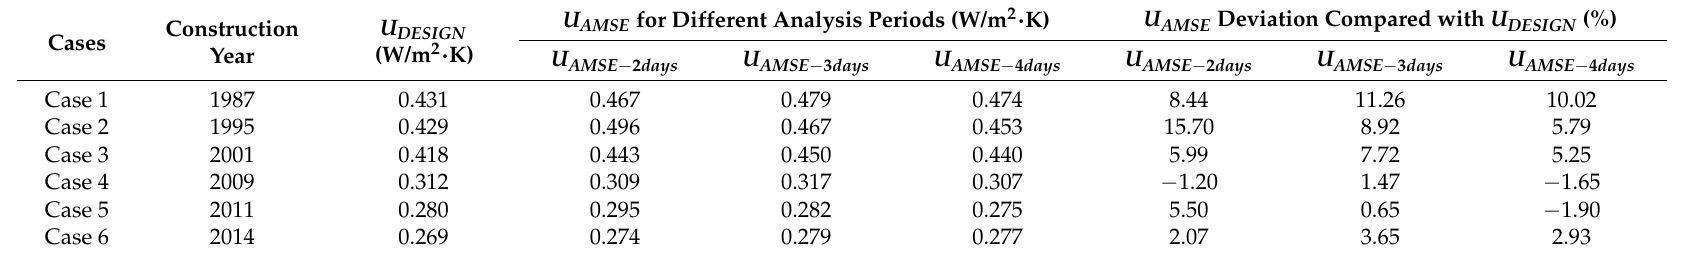
Table 3. Comparison between designed U -values and U -values corrected by applying the thermal storage